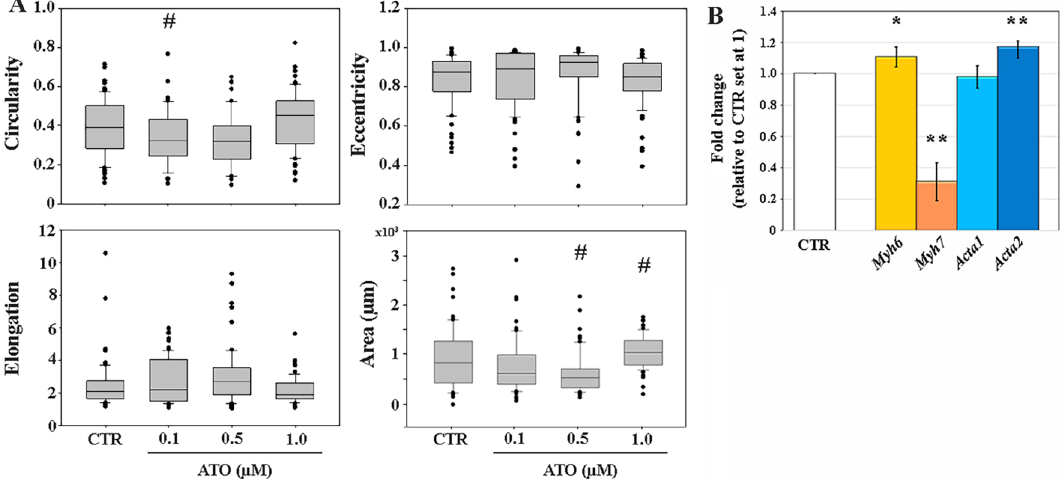
Figure 4. ( A ) Circularity, eccentricity, elongation and area values of control (CTR) and ATO-treated cardiomyocytes. The horizontal line within the box is the median, whereas the upper and lower lines are the 25th percentile and 75th percentile, respectively. The black dots are out-layer values. # p < 0.05. ( B ) Fold change of the expression profile of myh6 , myh7 , acta1 and acta2 genes, calculated for 1.0 µM ATO-samples. * p < 0.05; ** p <